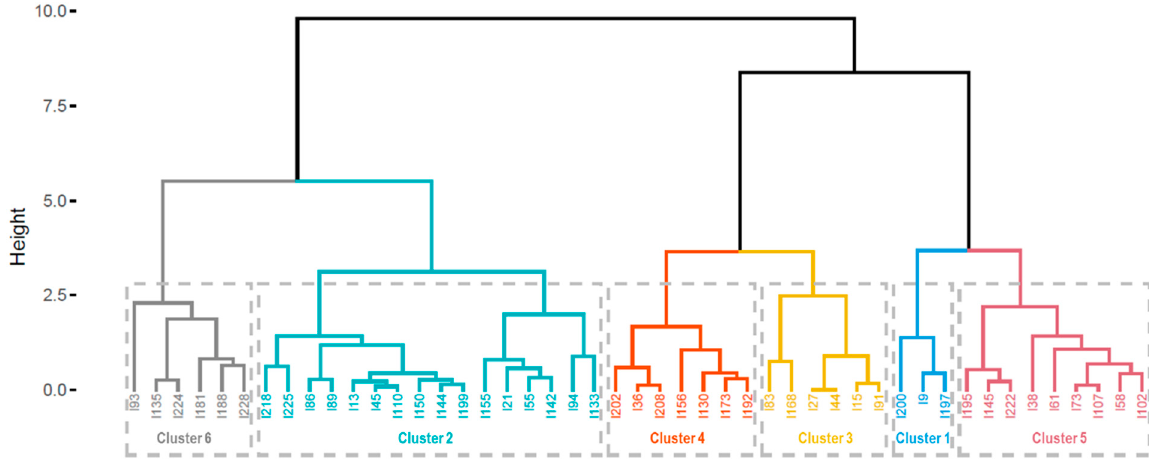
Figure 3. Hierarchical cluster dendrogram.